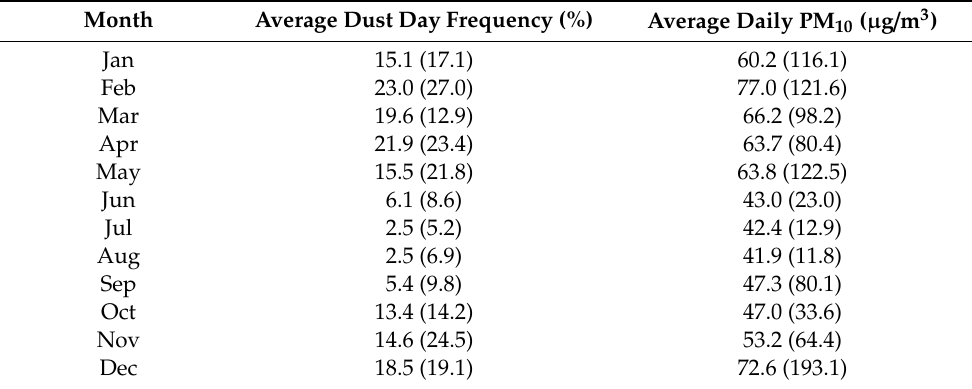
Table 1. Average monthly dust day frequency (%) and average daily PM 10 concentration ( µ g / m 3 ). Standard deviations are in